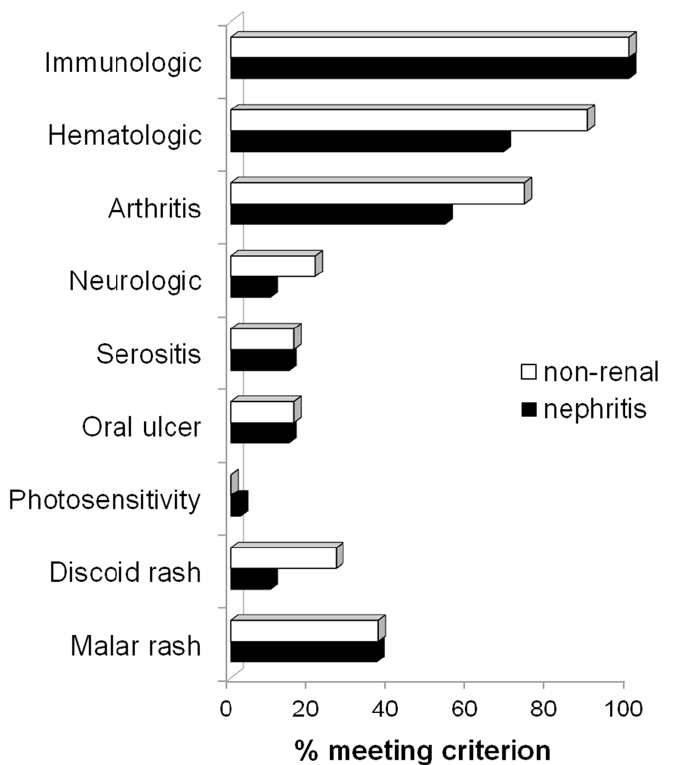
Figure 1. Proportion of ACR classification criteria met by males with childhood-onset SLE with and without nephritis. Patients who developed kidney involvement at any time during follow-up (biopsy not required, n = 59, black) were compared with those who never met criteria for kidney disease (based on ACR classification, n = 36, white bars). All patients tested positive for antinuclear antibodies. ACR = American College of Rheumatology. p -values < 0.05 for each comparison between lupus nephritis and non-renal subsets.